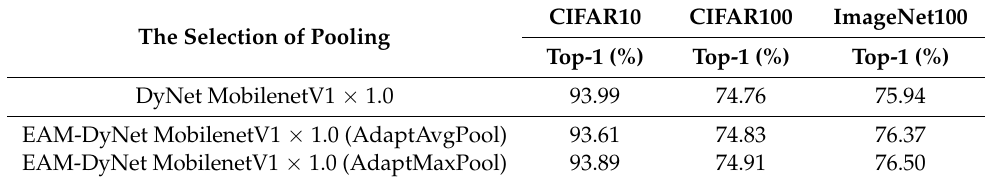
Table 6. The accuracy rate when using different pooling on EAM-DyNet MobilenetV1. The Selection of Pooling